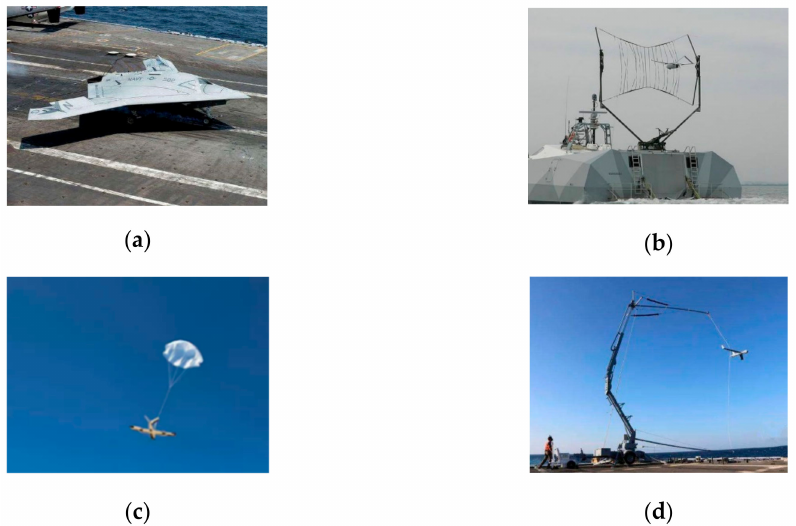
Figure 1. Several common small ship-based fixed-wing UAV recovery methods. ( a ) Runway arrested landing; ( b ) net recovery; ( c ) parachute / parafoil recovery; and ( d ) cable-hook